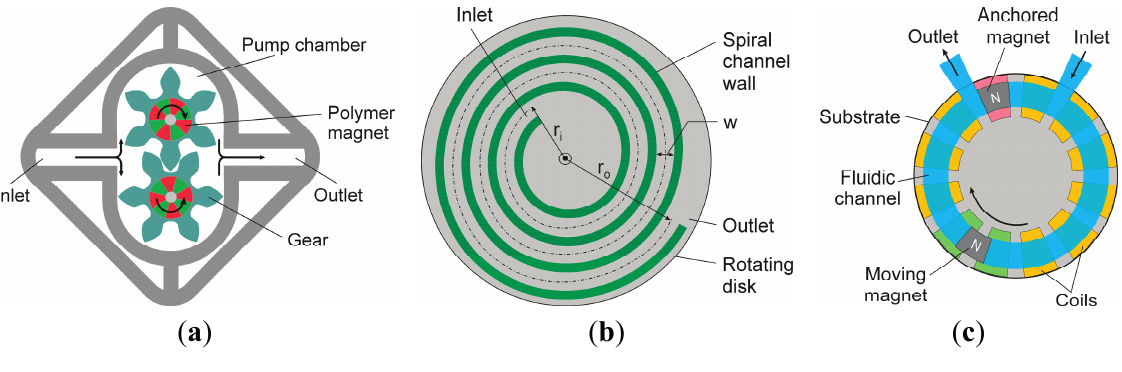
Figure 8. Concept of a meso-scale x - y positioning system (according to [39]).